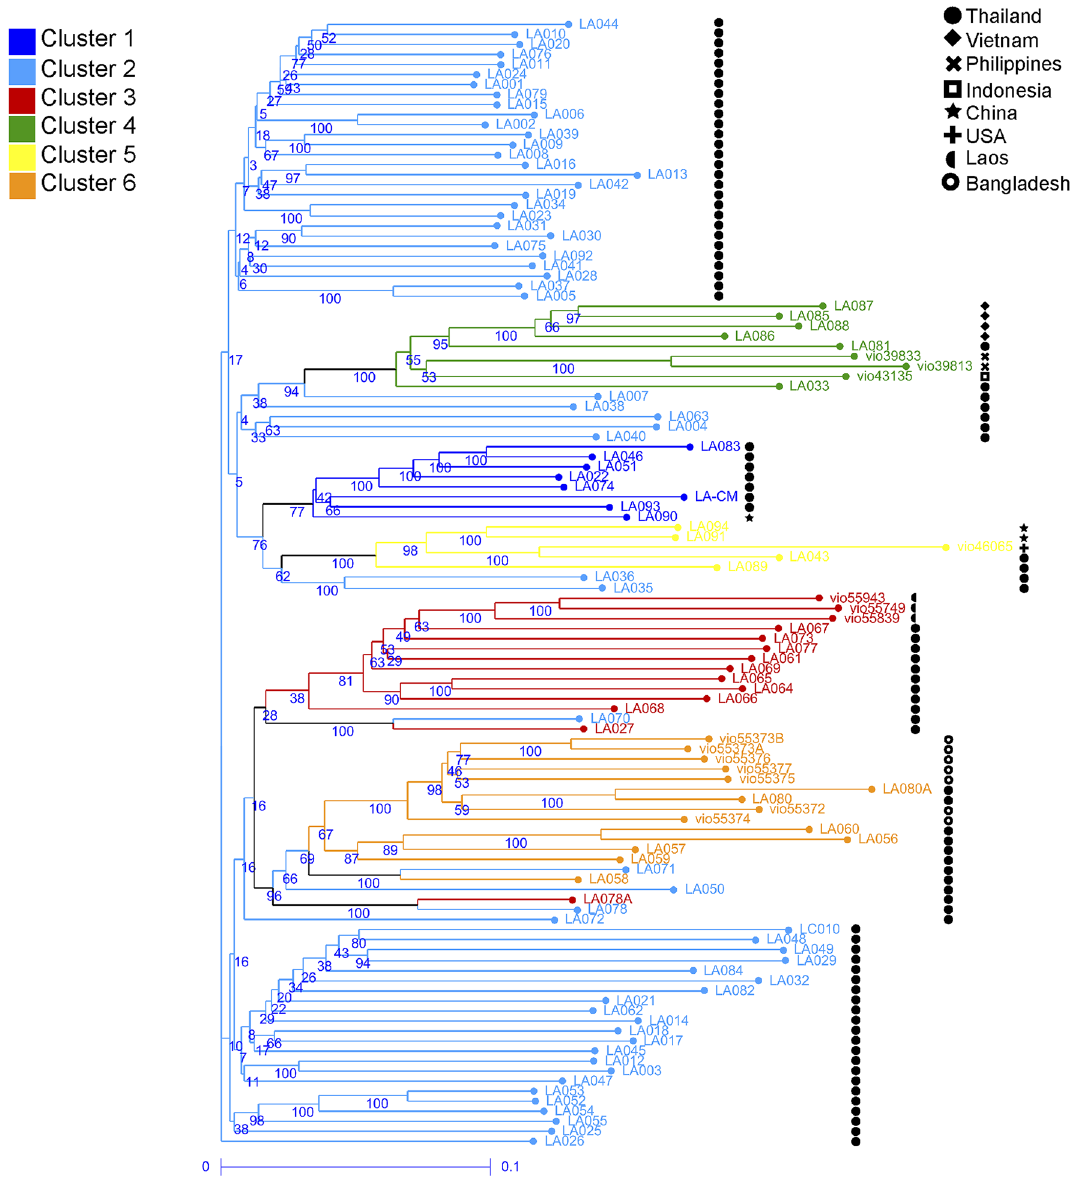
Figure 2. Weighted neighbor-joining dendrogram of 112 Luffa acutangula accessions based on DArTseq SNPs. Branch colors correspond to clustering by STRU CTU RE analysis. Symbols indicate accession’s country of